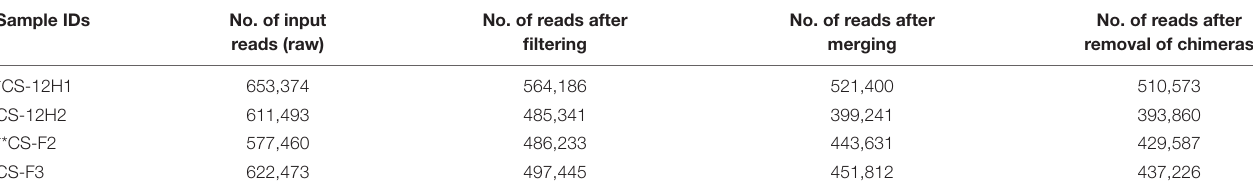
TABLE 2 | Fungal preprocessing reads count reduction information for Kalparasa samples using the DADA2 R package. Sample